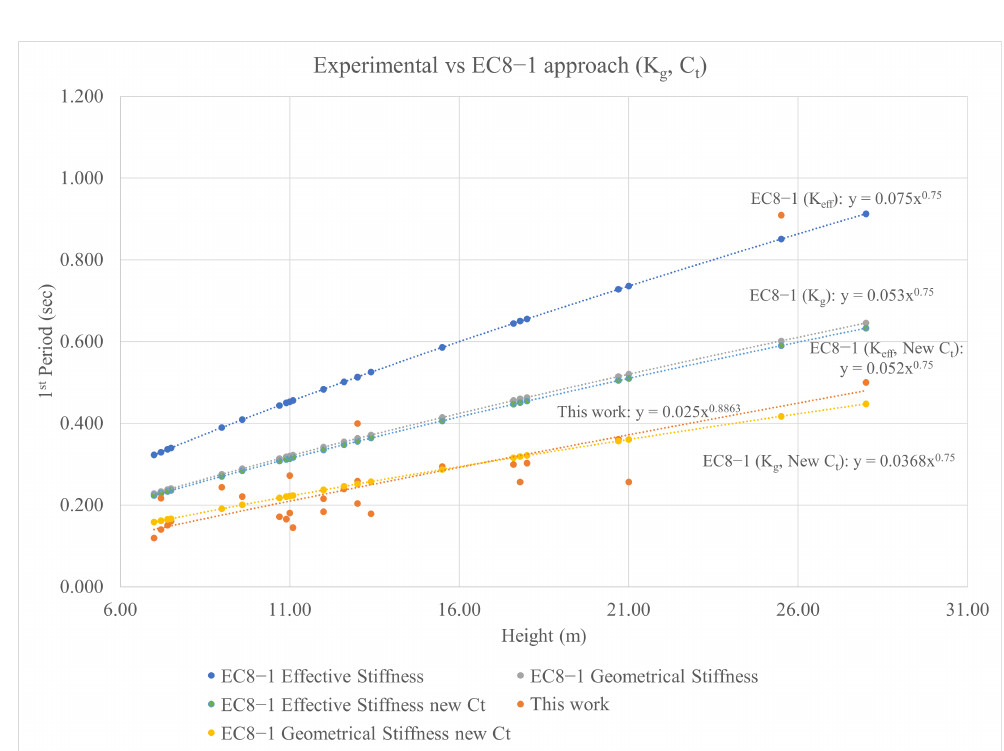
Figure A2. Experimental vs EC8’s expression ( Kg , C t